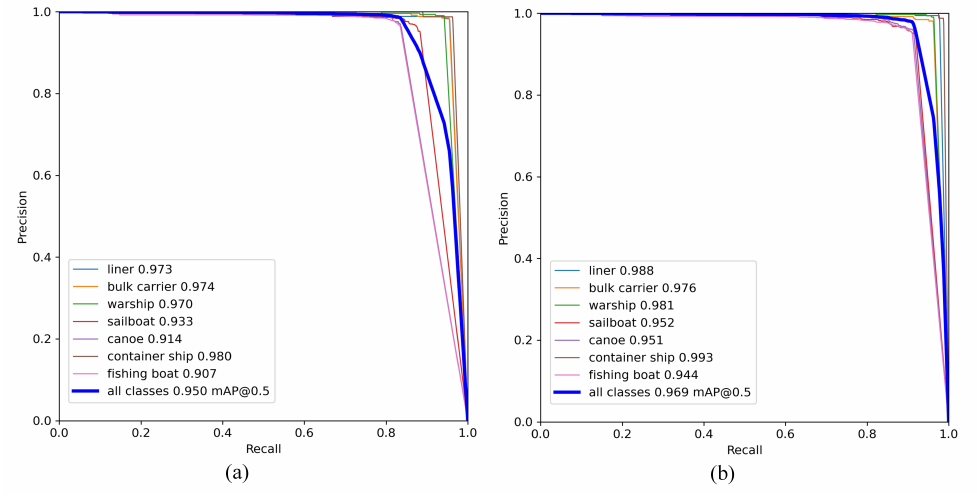
Figure 15. PR curve. ( a ) YOLOv5; ( b )